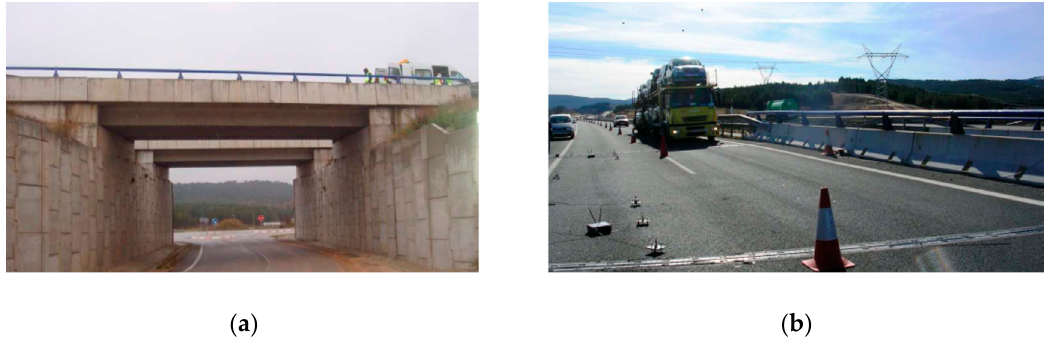
Figure 1. The skewed highway bridge: ( a ) Side view; ( b ) front view (during the measurements).